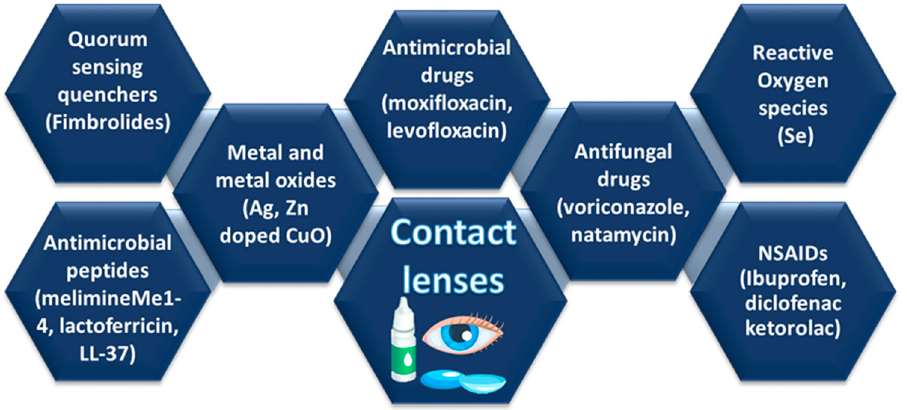
Figure 8. Antimicrobial strategies to fabricate microbiocidal contact lenses.